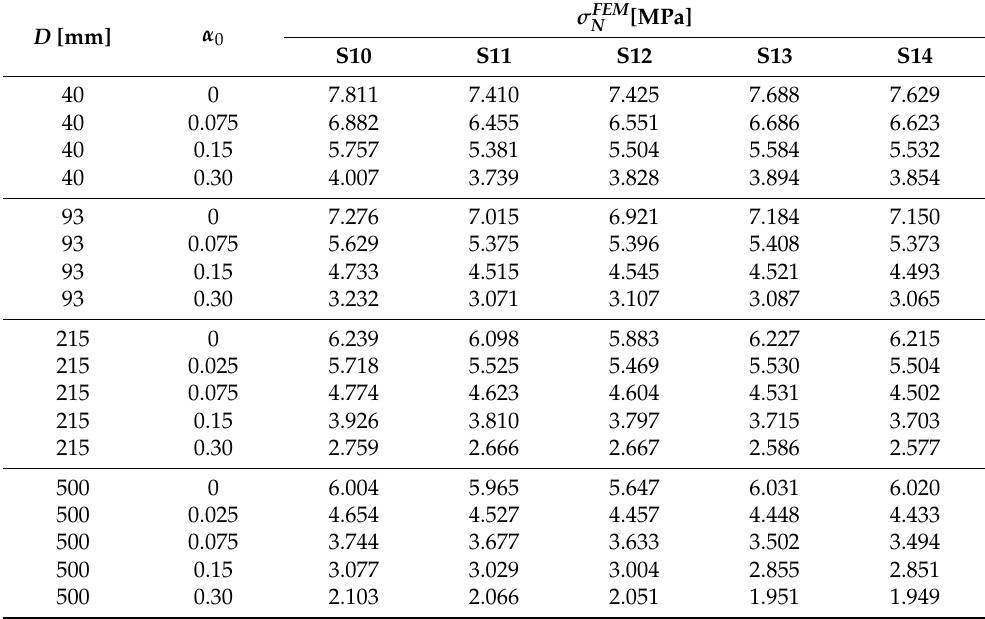
Table 4. Calculated nominal strengths σ FEM S13–S14) softening